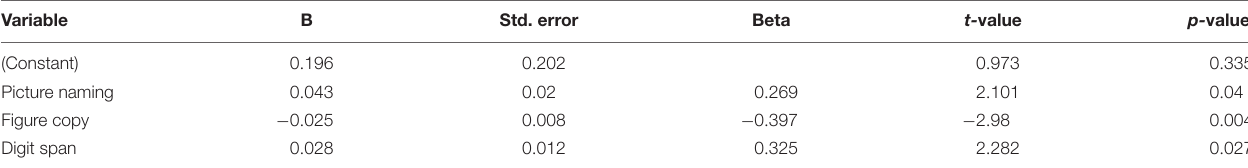
TABLE 4 | Multiple linear regression analysis of predictors of antidepressant efficacy in LLD.